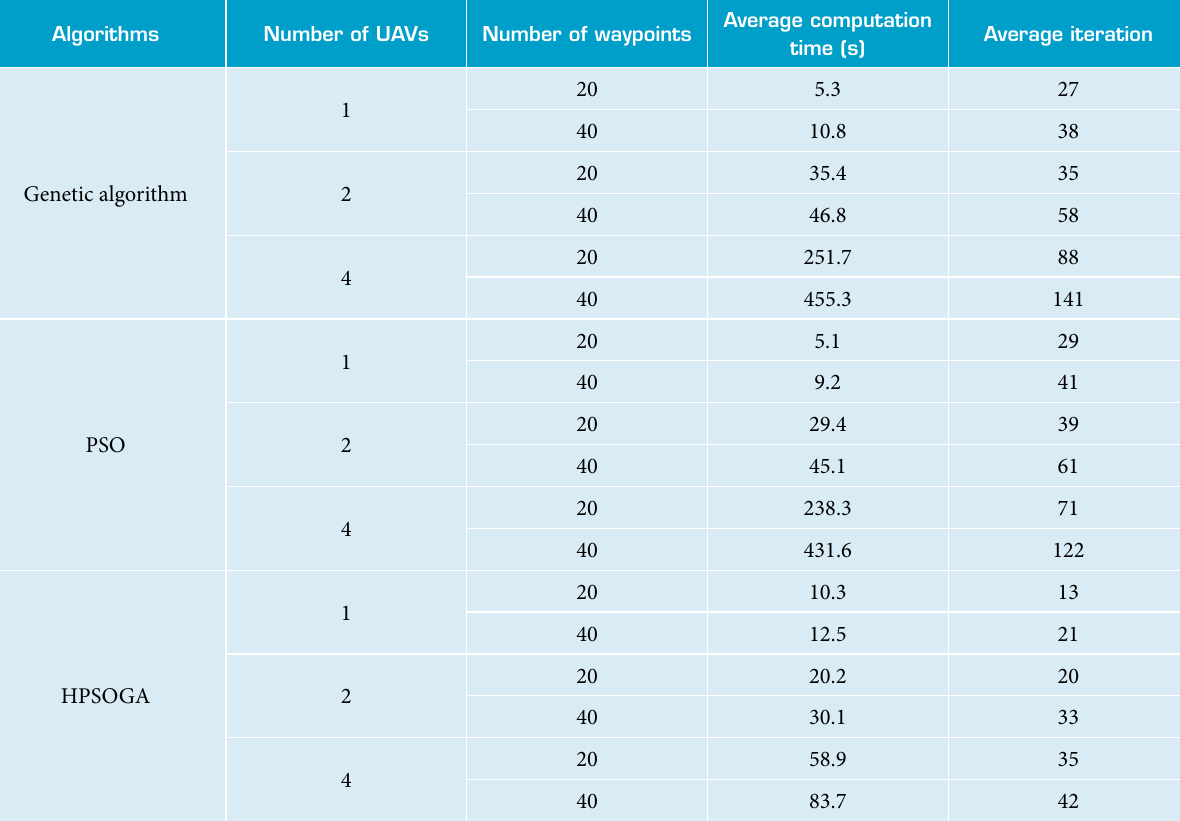
Table 1. Algorithms performance